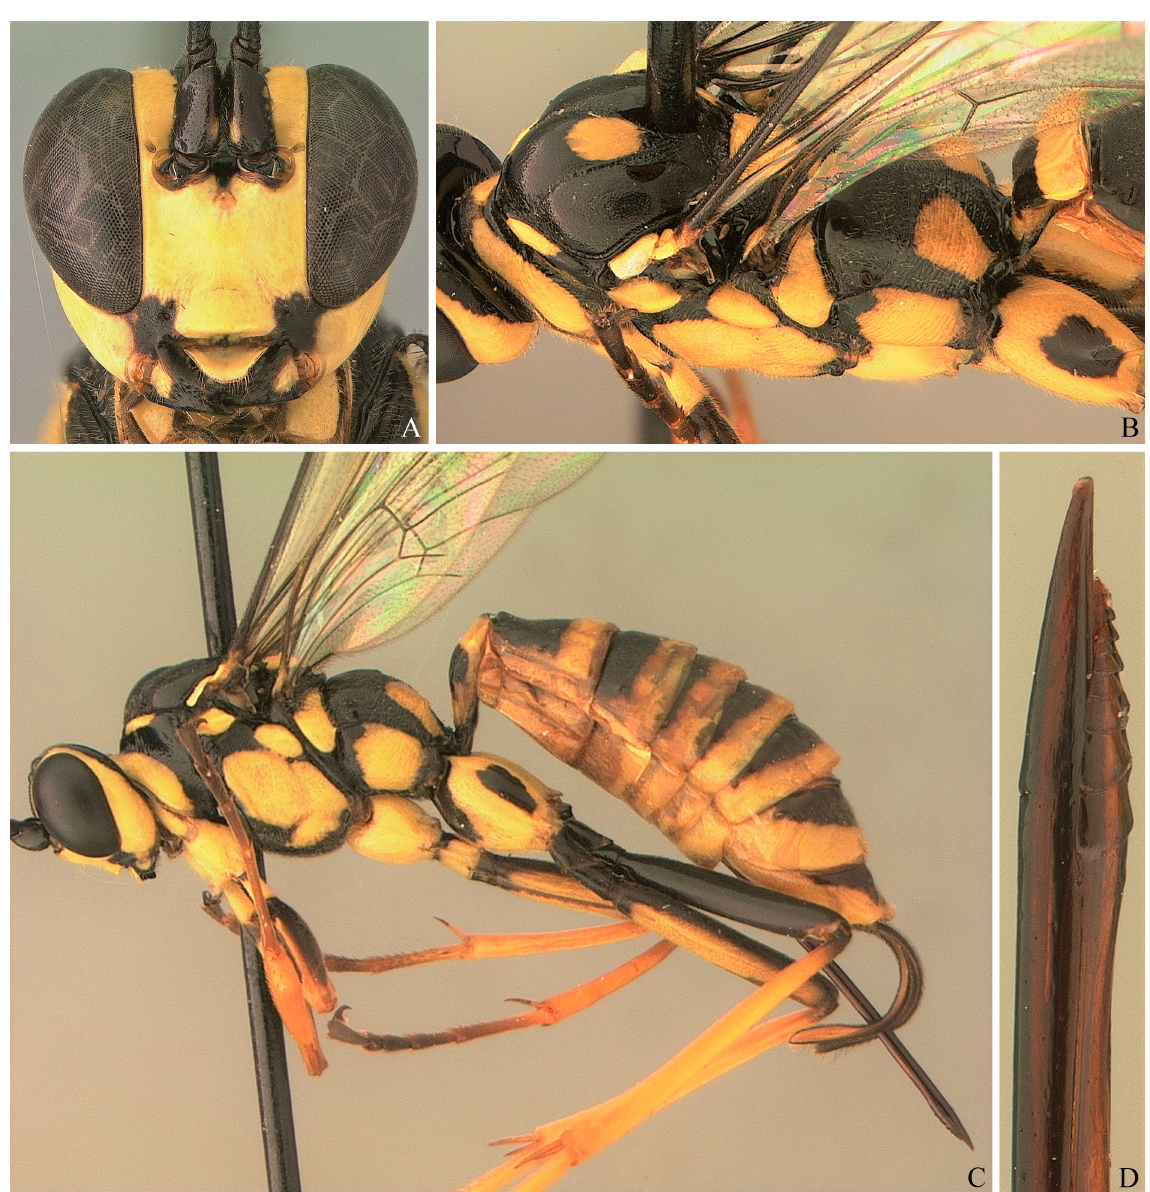
Fig. 11. Distictus mexicanus Kasparyan & Ruíz, 2005, paratype (USUC), ♀. A . Head, frontal view. B . Mesosoma, dorso-lateral view. C . Habitus. D . Apex of ovipositor,